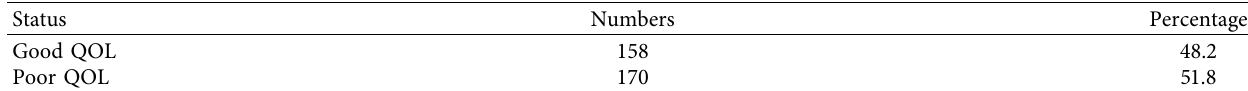
Table 5: Quality of life of the